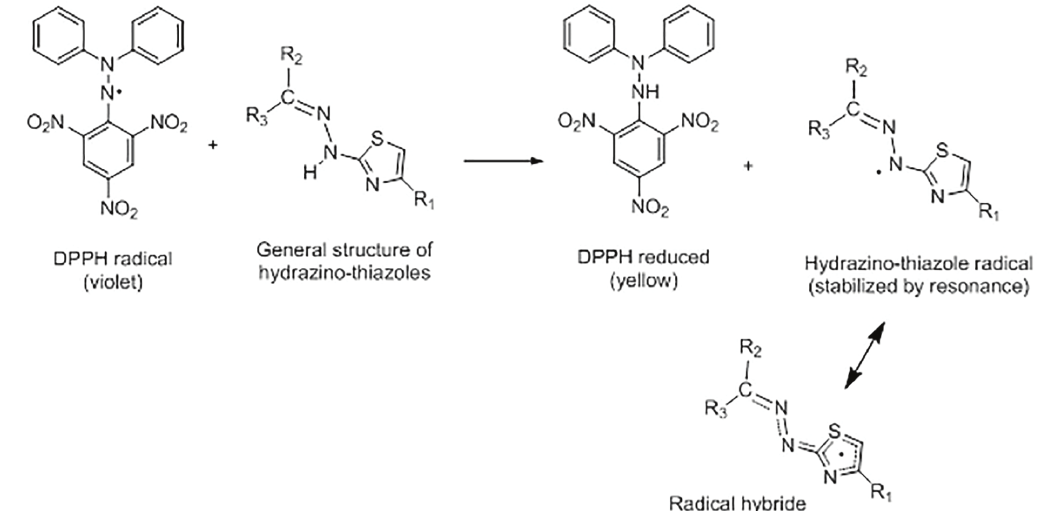
FIGURE 1 - Schematic representation of the reaction between DPPH radical and hydrazine-thiazole derivatives.